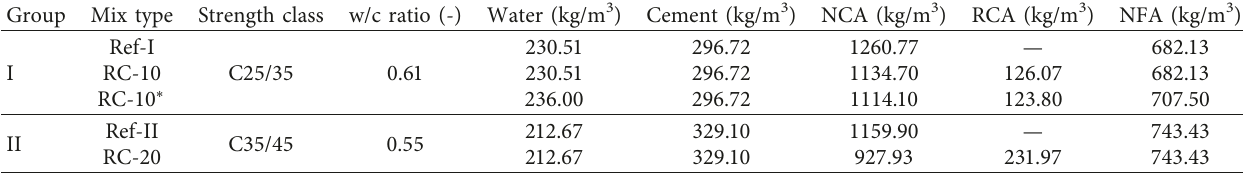
Table 1: Mix compositions of the concretes.